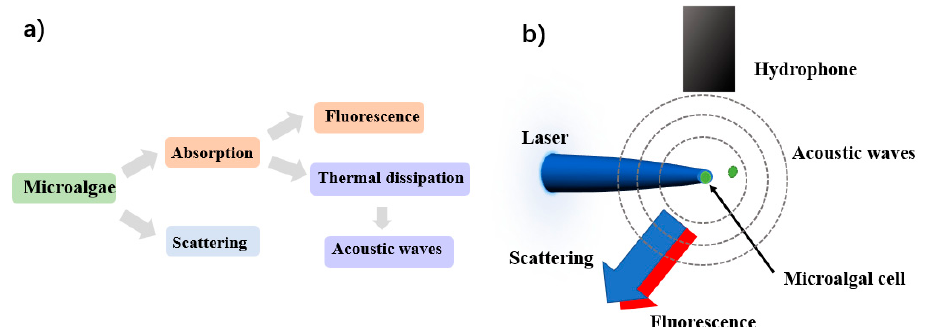
Figure 2. ( a ) The interaction processes between light and microalgae cell; ( b ) Detection schematic of the measurement.